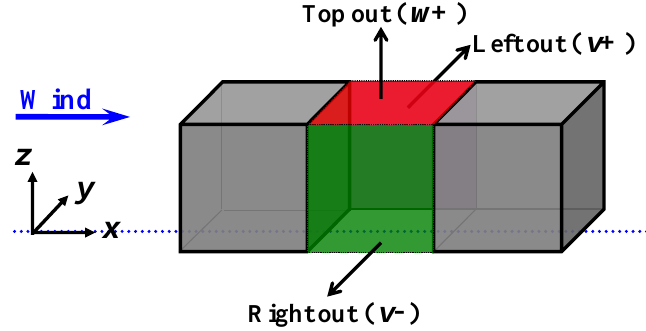
Figure 1. Sketch of three boundaries of a 3D street canyon and outflow definition.